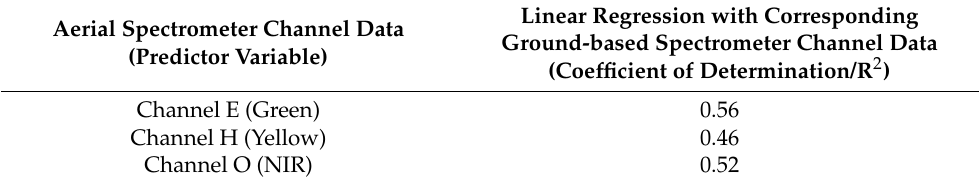
Table 5. Aerial green, yellow, and NIR channel linear regression with corresponding ground-based channel data.